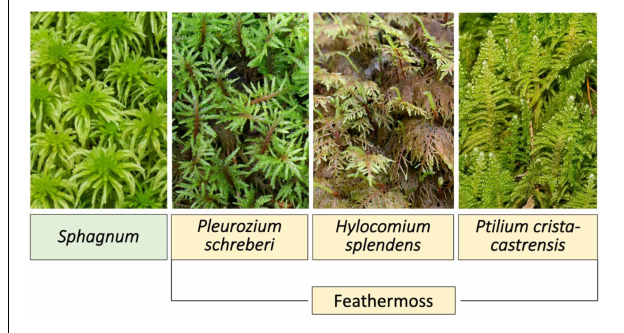
FIGURE 1 | Diagram displaying the moss groups Sphagnum and feathermoss, as well as feathermoss species Pleurozium schreberi , Hylocomium splendens , and Ptilium crista-castrensis , common to boreal black spruce ( Picea mariana ) forests.